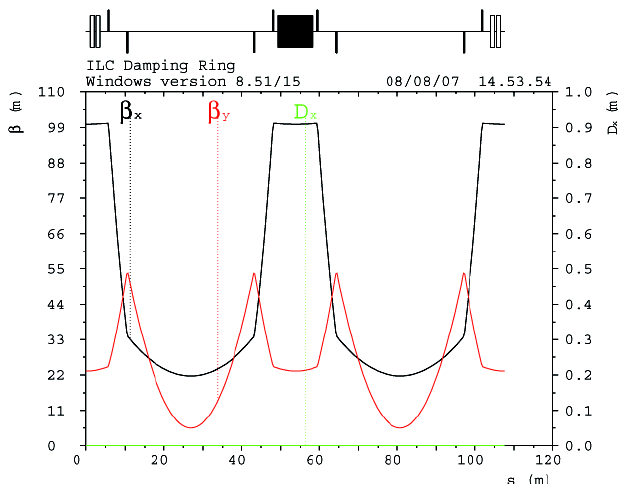
FIG. 4. (Color) Lattice functions in the injection/extraction sec- tions.